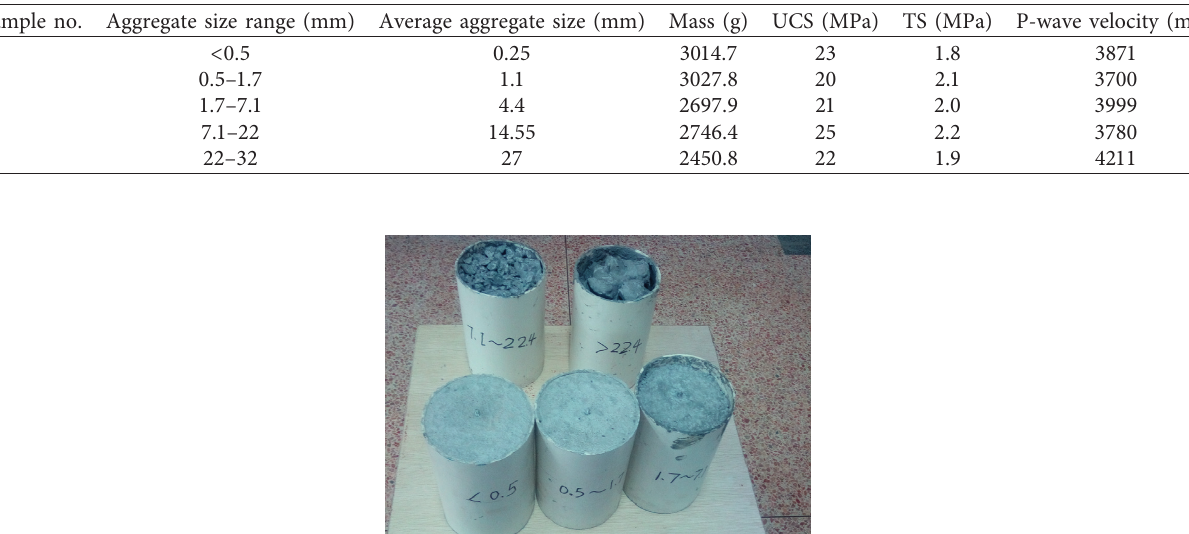
Table 1: Properties of rock samples.